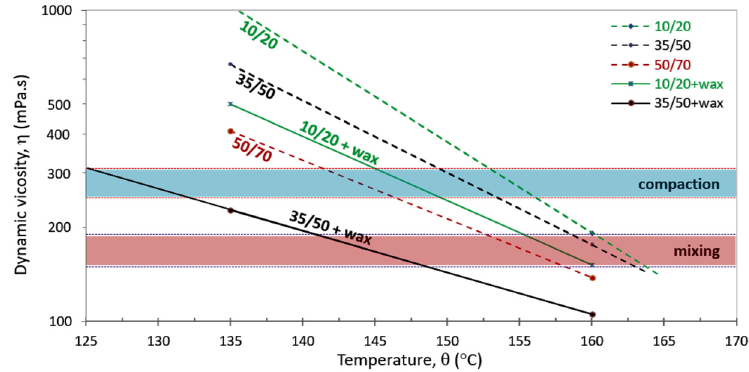
Figure 9. Dynamic viscosity of unmodified binders, with and without wax.